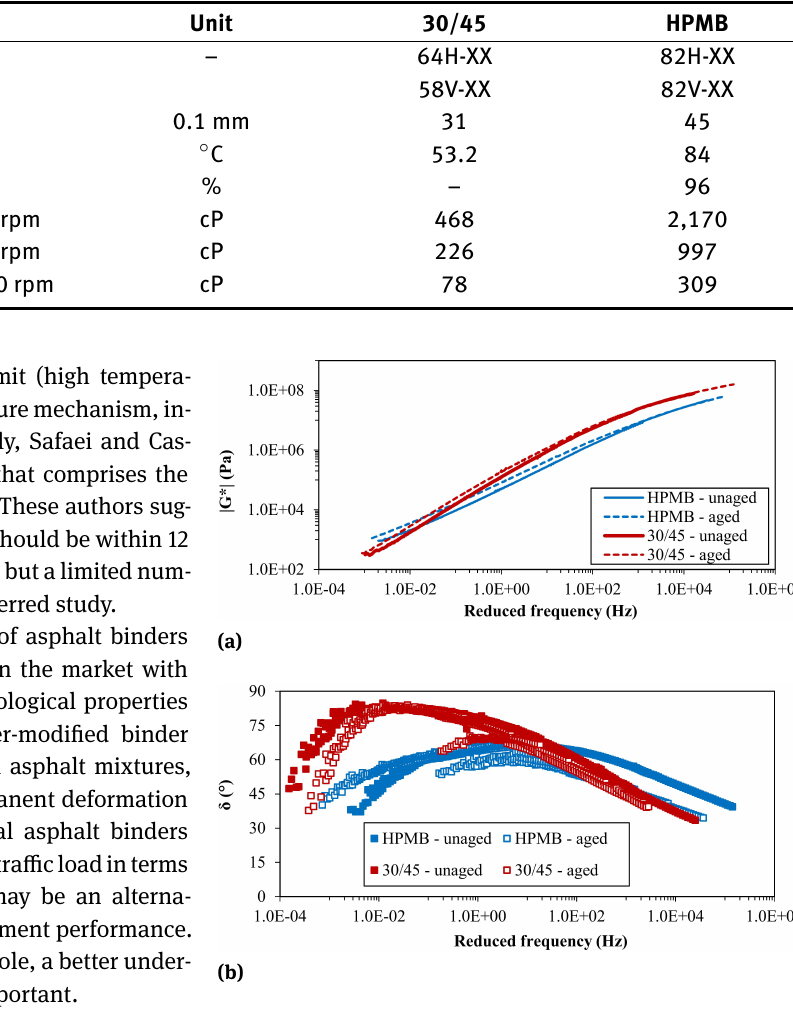
Table 1: Asphalt binders characteristics